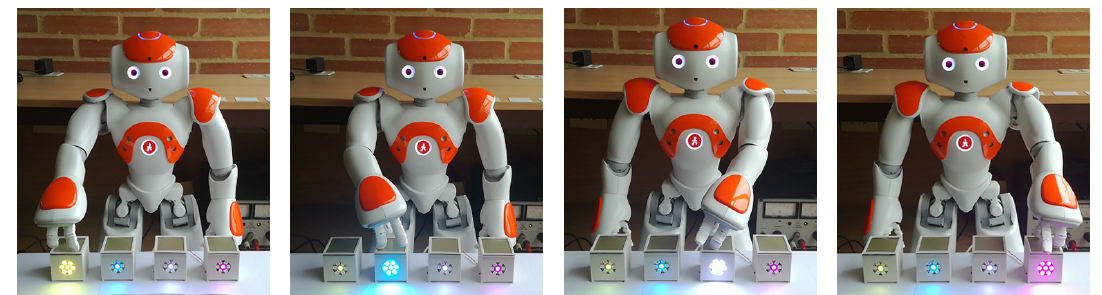
Figure 4. Robot Nao showing stimulus.